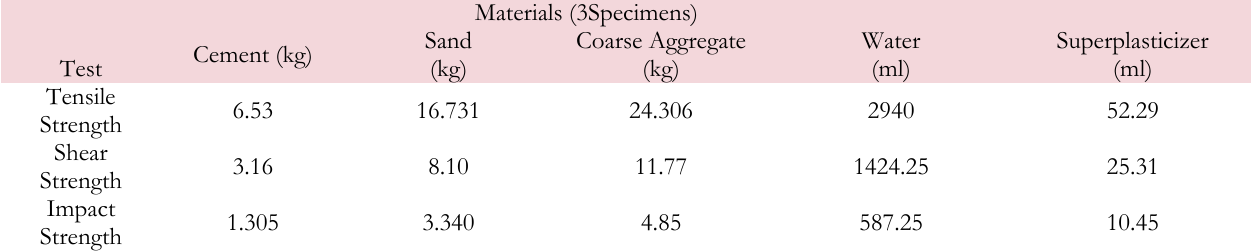
Table 2: Mixing proportion to prepare the concrete